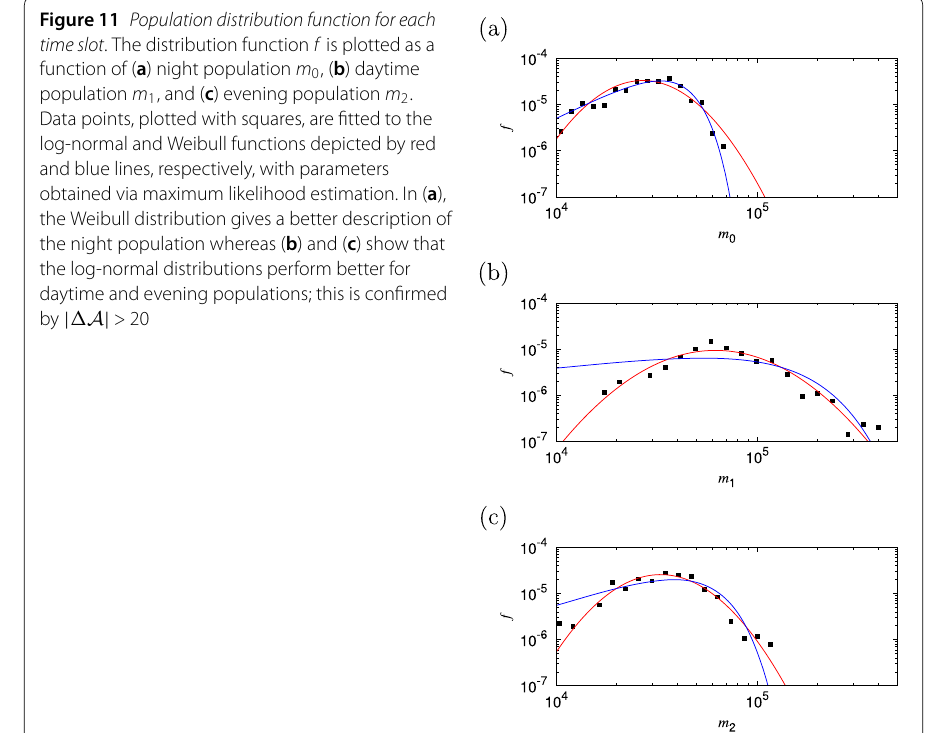
Figure 11 Populationdistributionfunctionforeach timeslot . The distribution function f is plotted as a function of ( a ) night population m 0 , ( b ) daytime population m 1 , and ( c ) evening population m 2 . Data points, plotted with squares, are fitted to the log-normal and Weibull functions depicted by red and blue lines, respectively, with parameters obtained via maximum likelihood estimation. In ( a ), the Weibull distribution gives a better description of the night population whereas ( b ) and ( c ) show that the log-normal distributions perform better for daytime and evening populations; this is confirmed by | (cid:10) A | > 20